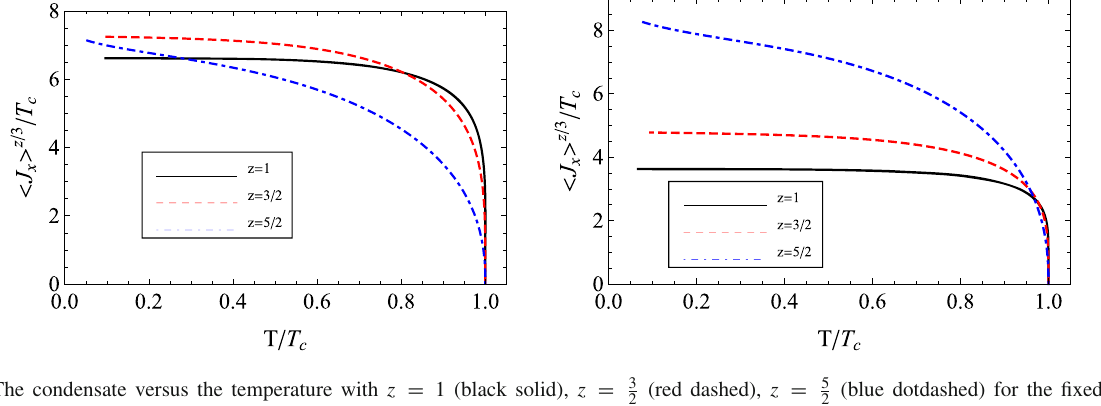
(the right panel) 100